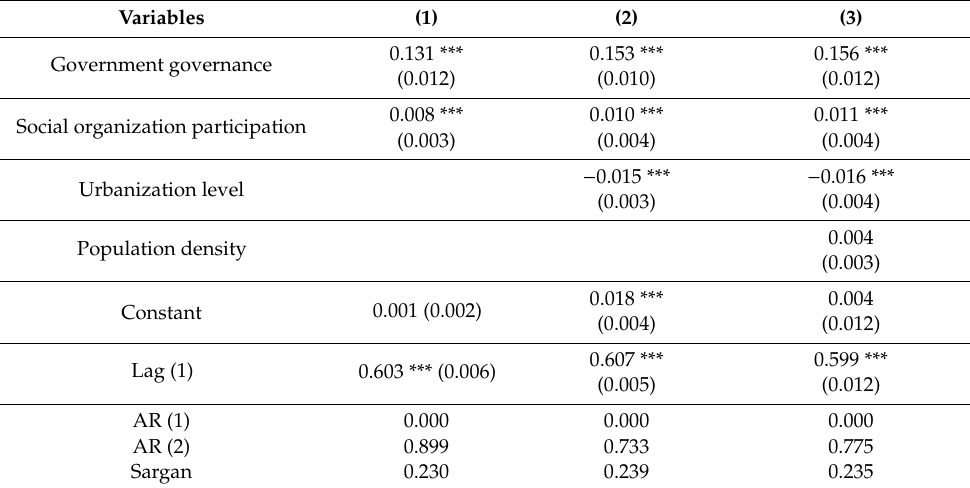
Table 4. Benchmark regression